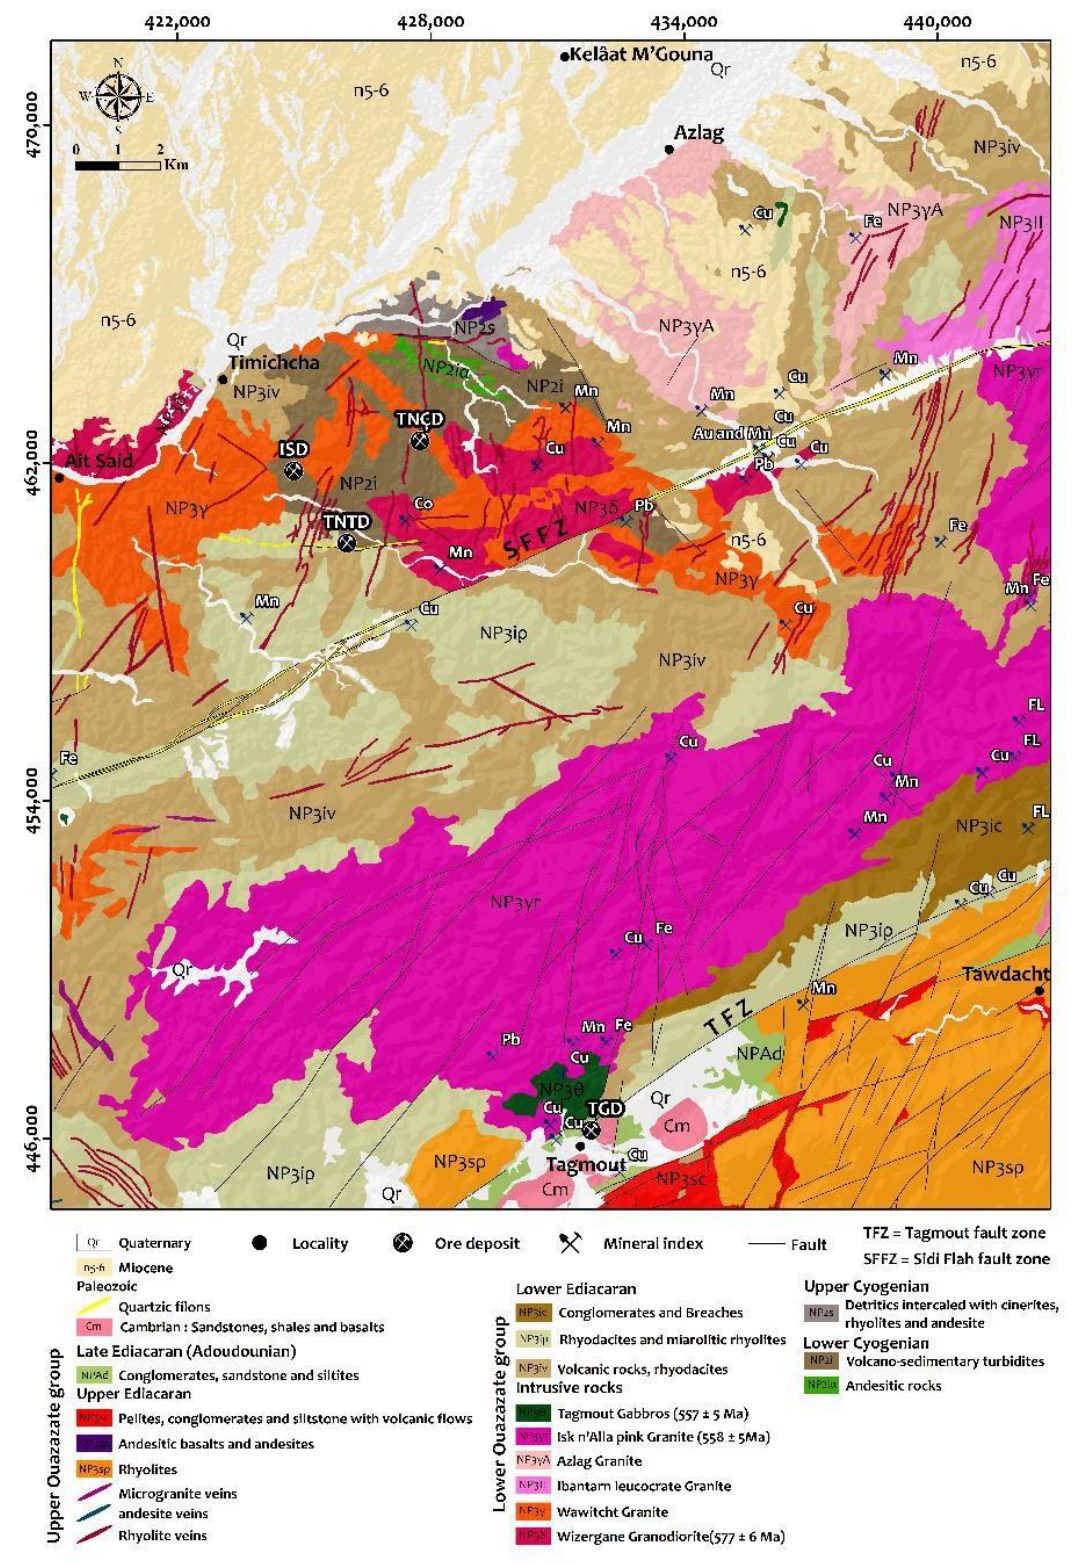
Figure 2. Geological map of the study area extracted from the geological map 1:50,000 of Kelâat M’Gouna, showing its main ore deposits (ISD: Ismlal gold Deposit; TNÇD: Taourirt-n-Çwalh gold Deposit; TNTD: Talat-n-Tbarought gold Deposit; TGD: Tagmout copper Deposit).